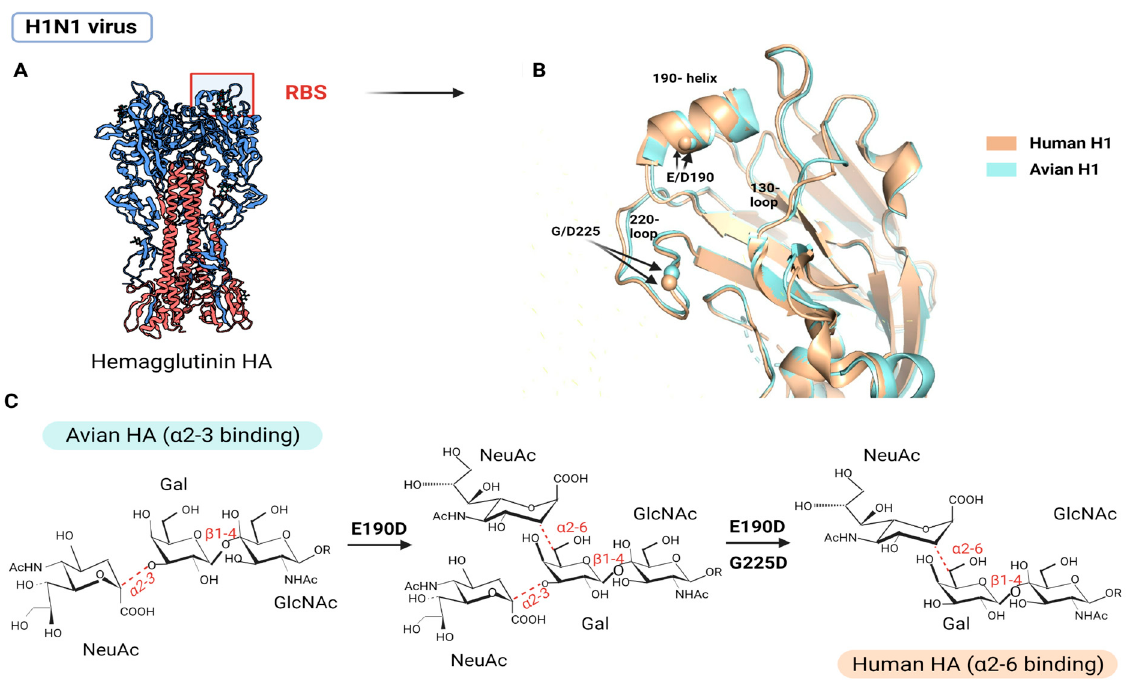
Figure 4. E190D and G225D substitution in H1N1. ( A ) Overall trimeric structure of HA of IAV H1N1. The location of RBS is marked. ( B ) Comparison of the structural characteristics and amino acid positions of avian (cyan) and human (beige) H1 RBS proteins. ( C ) The impact of specific receptor- binding variants on viral receptor specificity that facilitated the entry of H1N1 into the human cells. Adapted from ref. [101]. Created using Pymol (Schrodinger LLC) with PDB IDs 1RV0 and 1RVZ, and with BioRender.com (accessed on 18 March 2023).